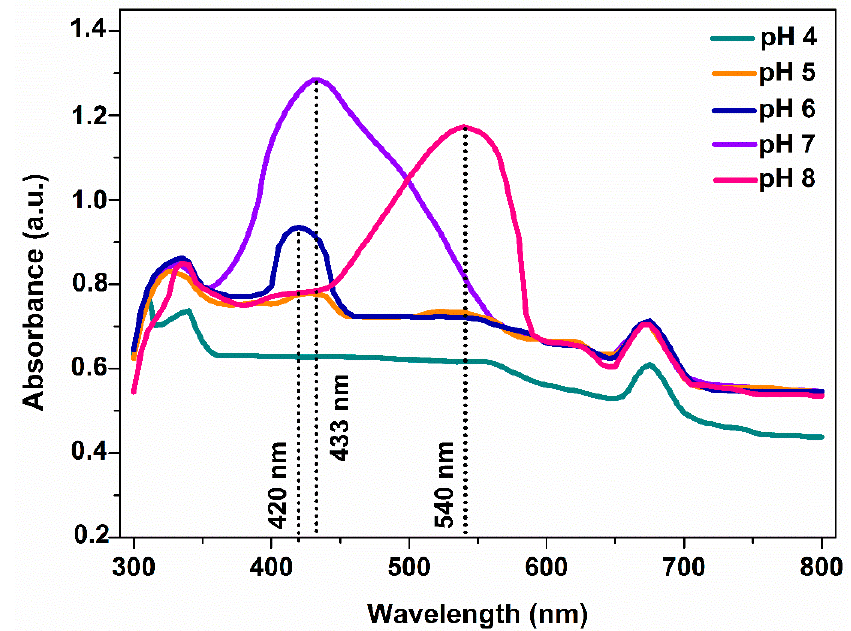
Figure 1. UV-vis spectra of AgNPs synthesized at different pH values.